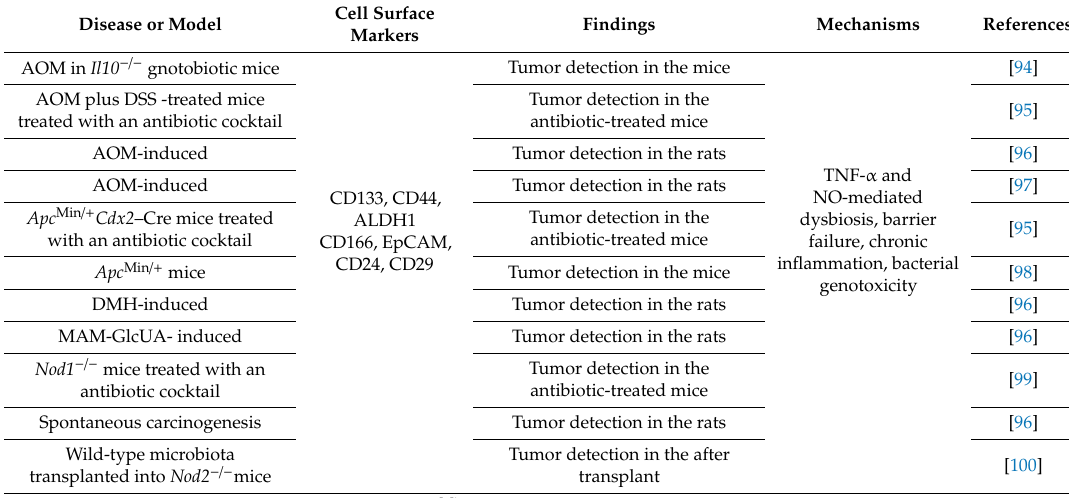
Table 2. Tumorigenic e ff ects of colon cancer stem cells